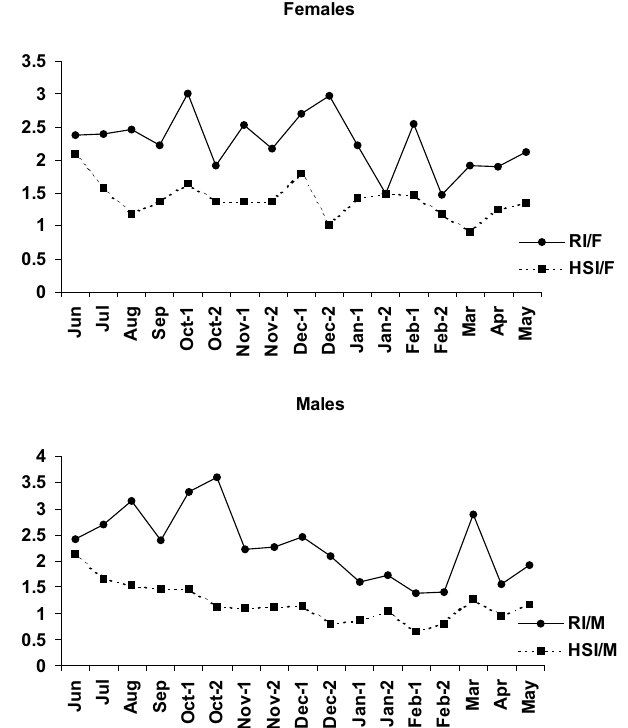
Fig. 2. Monthly distribution of the repletion (RI) and hepatosomatic indexes (HsI) average values of Eigenmannia trilineata males and females.